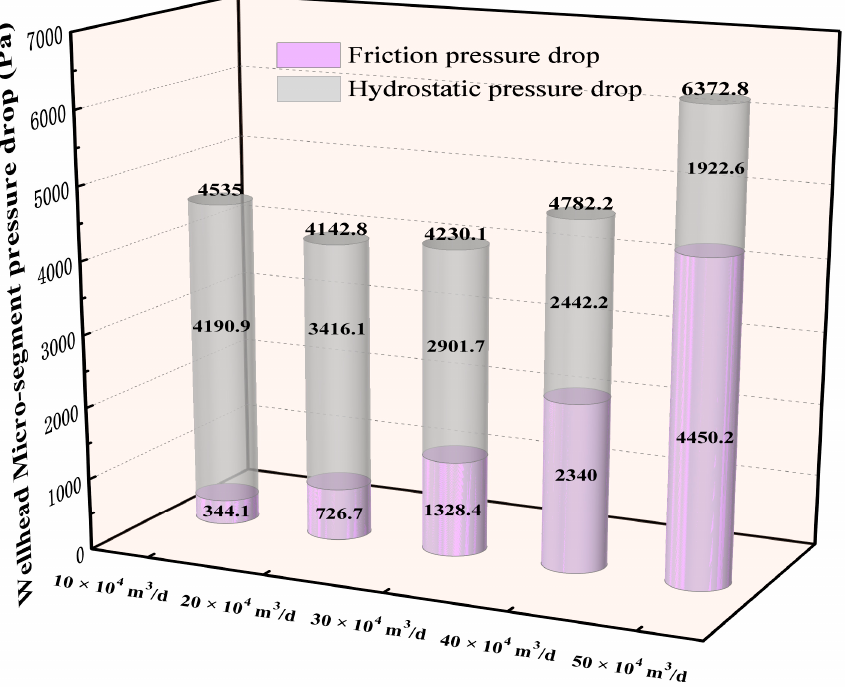
Figure 10. The pressure drop in the micro-segment of the wellhead.